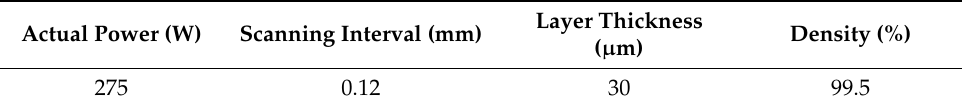
Figure 9. Experimental apparatus : ( a ) SLM500HL laser melting rapid prototyping machine; ( b ) universal material testing machine. Figure 10. Selective laser melting (SLM) forming sample of AFCC and BCC structures with dimensions of 32 mm × 32 mm × 32 mm.